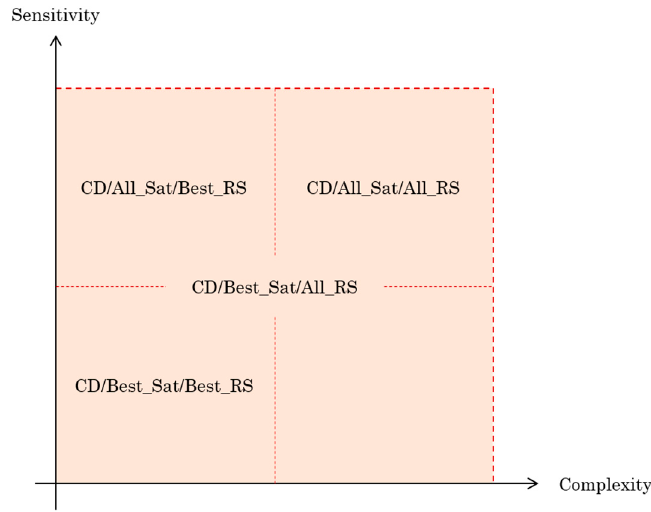
Figure 9. Compromise Sensitivity-Complexity of all 4 CD algorithms.